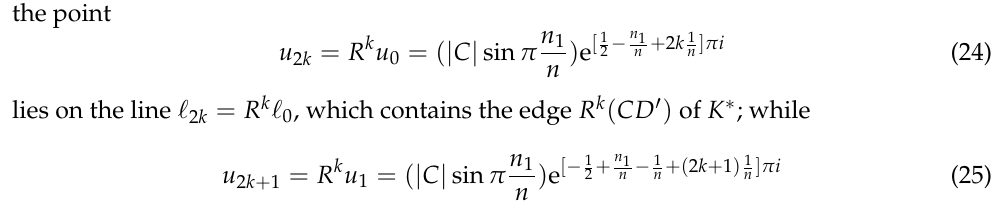
is the distance from n 0 to O and u 1